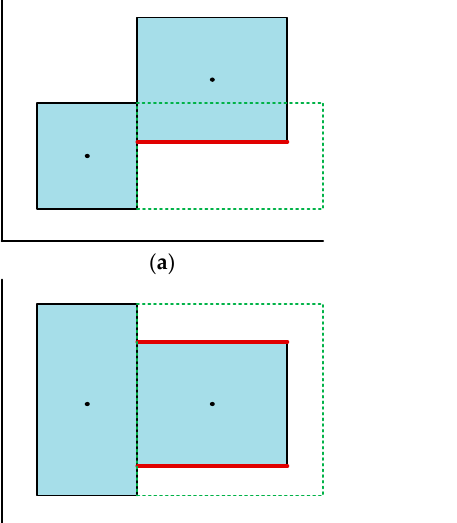
10 of 20 According to Figure 8, (cid:1855) (cid:3036)(cid:3051) is a coordinate from the west corner of Department (cid:1861) on the (cid:1876) axis. In the same way, (cid:1855) (cid:3036)(cid:3052) is a coordinate from the south corner of Department (cid:1861) on the (cid:1877) axis. (cid:1864) (cid:3036)(cid:3051) and (cid:1864) (cid:3036)(cid:3052) are the horizontal and vertical length of Department (cid:1861) on each axis, respectively. The following description is an example of the adjacent rules between Departments (cid:1861) and (cid:1862) on the (cid:1877) axis. At least one adjacent rule must be satisfied. The examples of adjacent rules can be seen in Figure 9. In this process, adjacent duplication is allowed because the reverse adjacent case of the departments must be considered. As shown in Figure 10, if the departments only share a vertex, this case is not regarded as an adjacency. Figure 8. The example of coordinates.